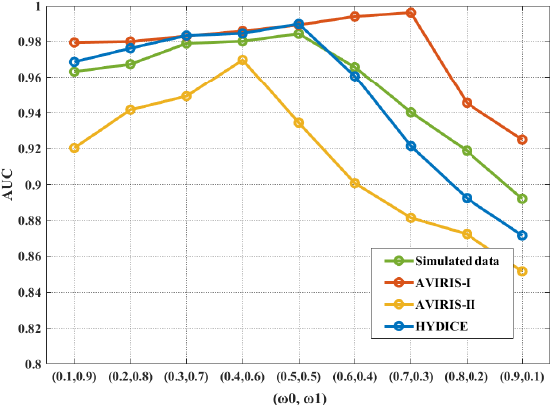
Figure 15. Analysis of fusion weights ( ω 0 , ω 1 ) on four different